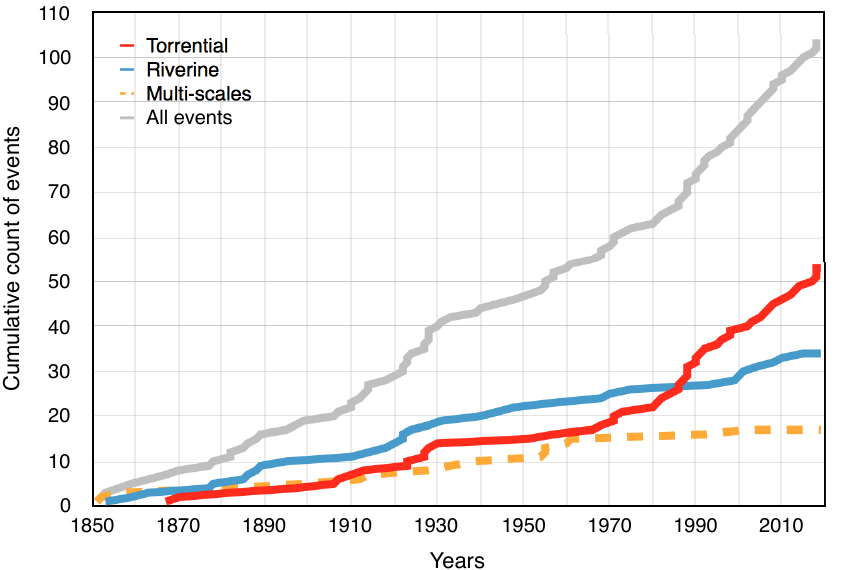
Figure 7. Cumulative count of Metropolitan flood events over the period 1850–2019. In total 104, Metropolitan events (light grey curve) have been selected over the period. The cumulative counts for events that occurred on rivers only (blue curve); on torrents only (red curve); and the multiscale events, i.e., co-occurrence of torrential and riverine flooding (dotted orange curve), are also plotted in the same coordinate systems, with the years ( x -Axis) and the event counts ( y